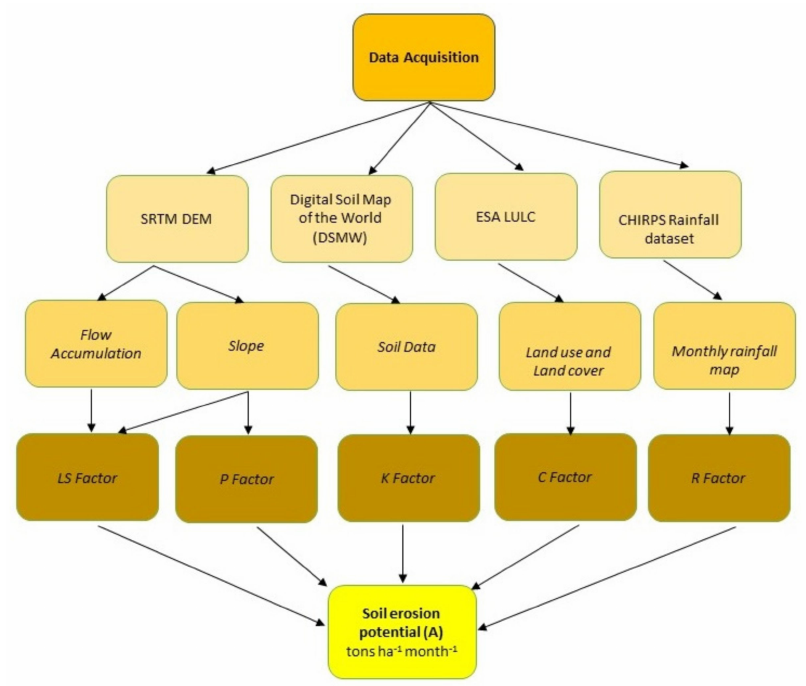
Figure 3. Flow chart for estimation of potential soil erosion and sediment